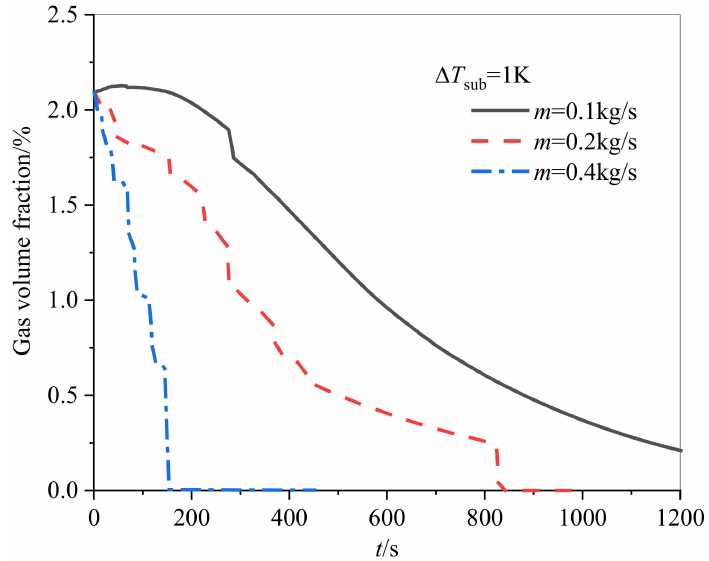
Figure 10. Influence of flow rate on gas volume fraction variation during circulation flow